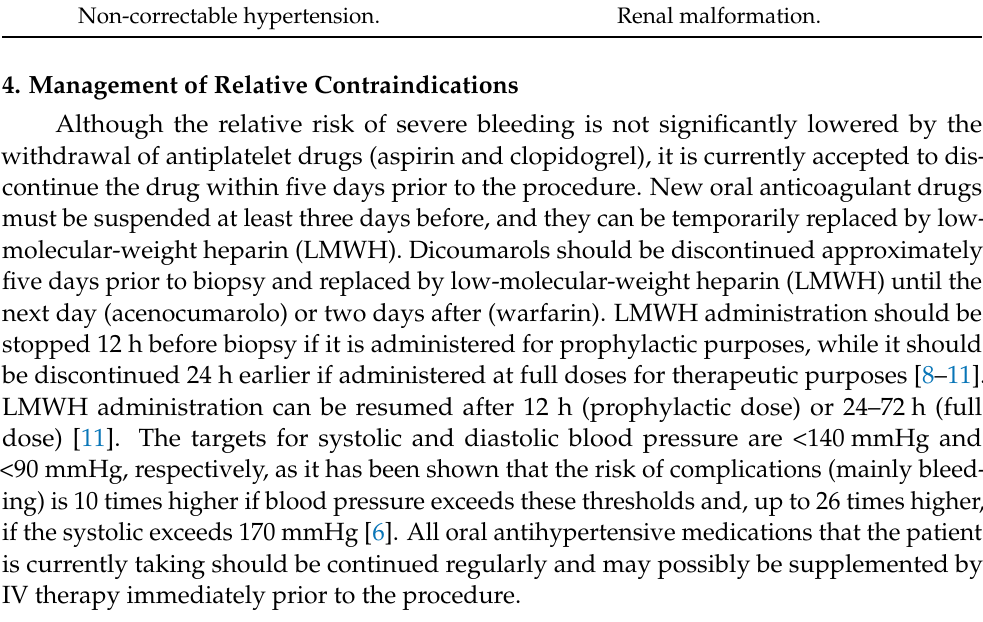
Table 2. Absolute and relative contraindications for performing renal biopsy [6–8]. Absolute Relative Therapy with antiplatelet agents, heparins or oral Non-correctable coagulopathy (INR >1.5). anticoagulants (to be suspended before the procedure; see main text). Hypertension (management with oral or IV drugs Lack of safe access. before the procedure). Platelet counts below 50,000/ × 10 9 /L. Abscess. Non-correctable hypertension. Renal